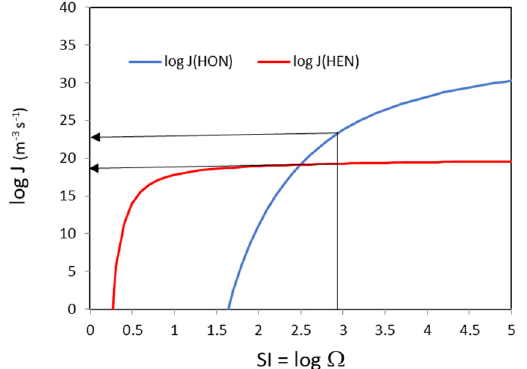
Figure A1. Graph comparing the homogenous versus heterogenous nucleation rate under our experimental conditions.